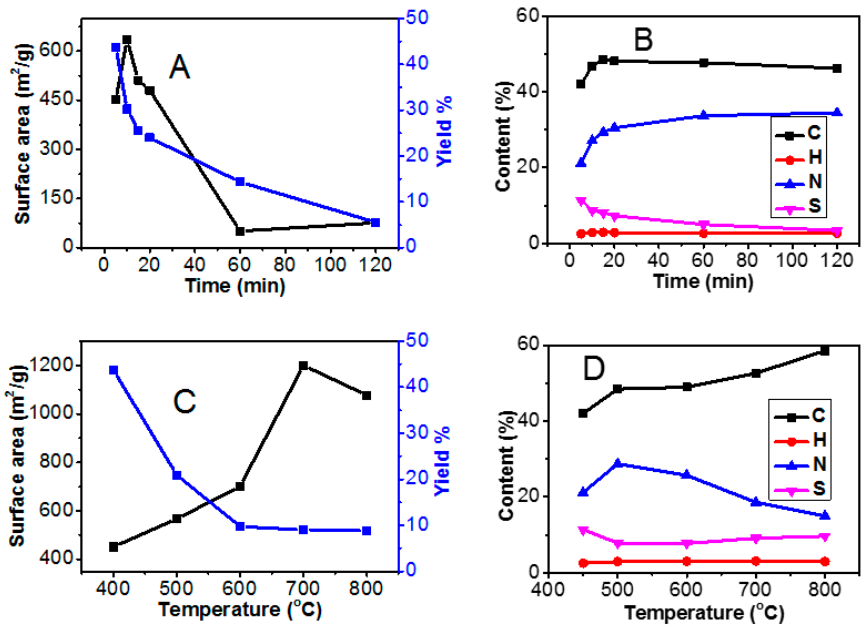
Figure 1. Plots of ( A ) carbonization yield and S BET (Brunauer–Emmett–Teller specific surface area) vs. the pyrolysis time (Entries 1–6 in Table 1); ( B ) the C/H/N/S content of carbon products prepared at 450 °C at different time; ( C ) carbonization yield and S BET vs. the pyrolysis temperature (Entries 7–10 in Table 1); ( D ) the C/H/N/S content of carbon products prepared via 5 min pyrolysis at different temperatures.